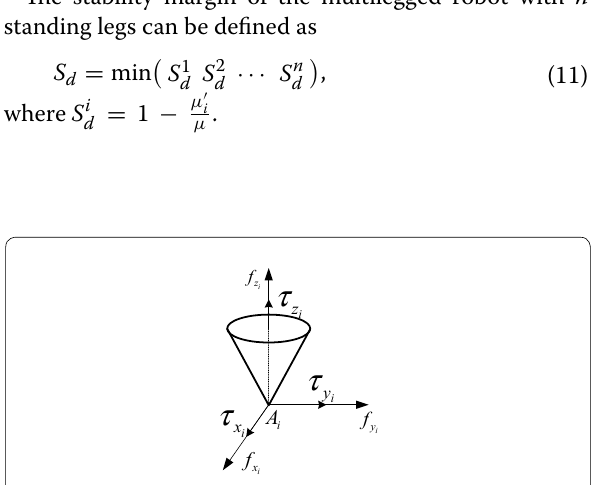
Figure 13 Force diagram of standing foot